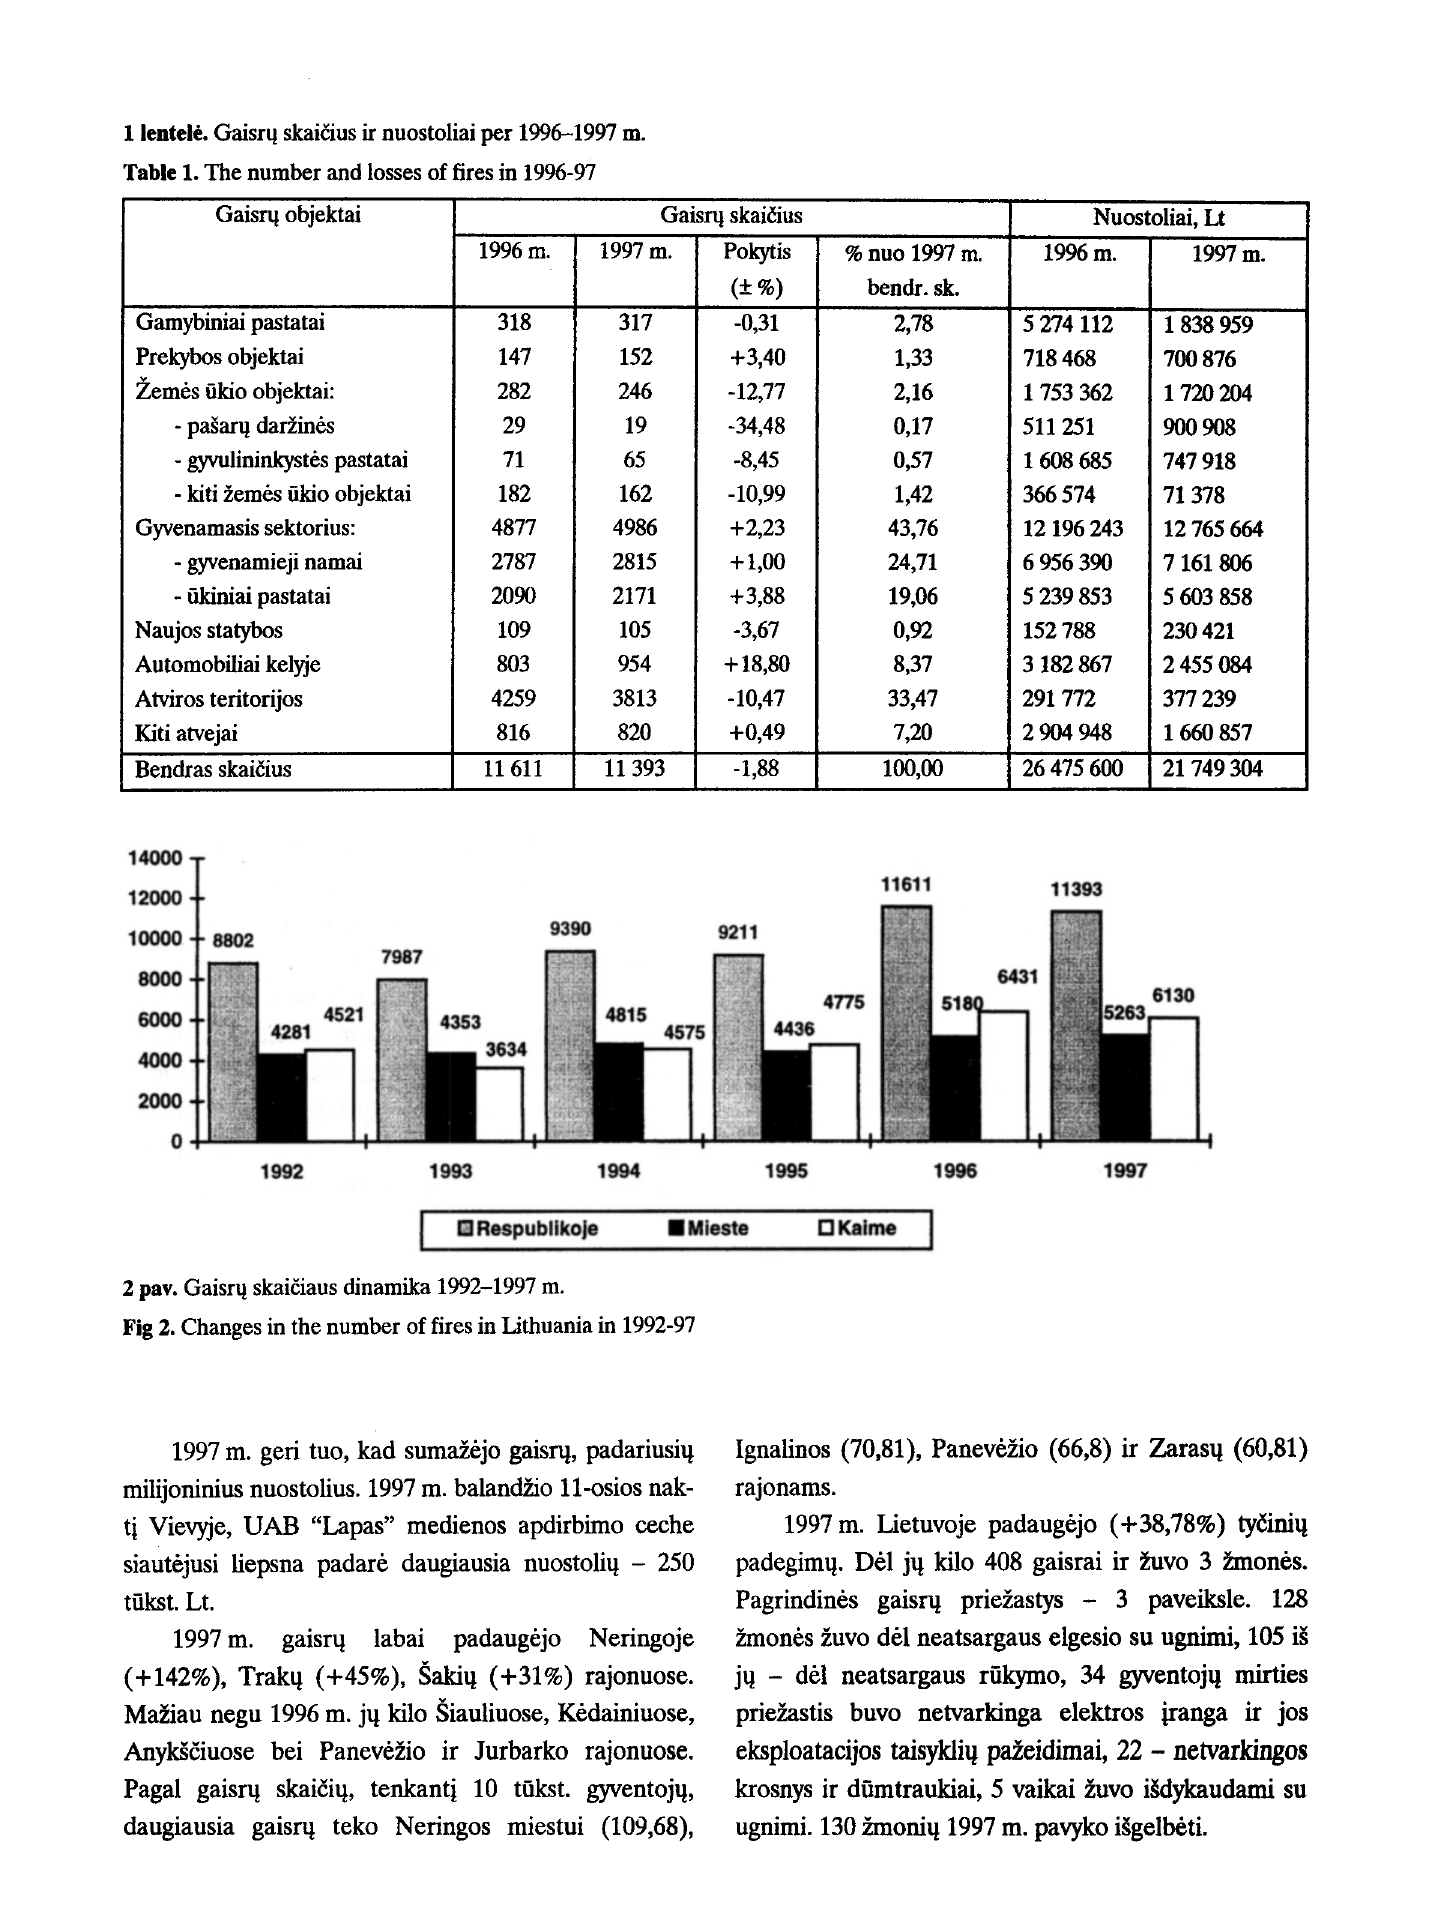
Table 1. The number and losses of fires in 1996-97 Gaisr4 objektai Gaisr4 skaiCius 1996 m.